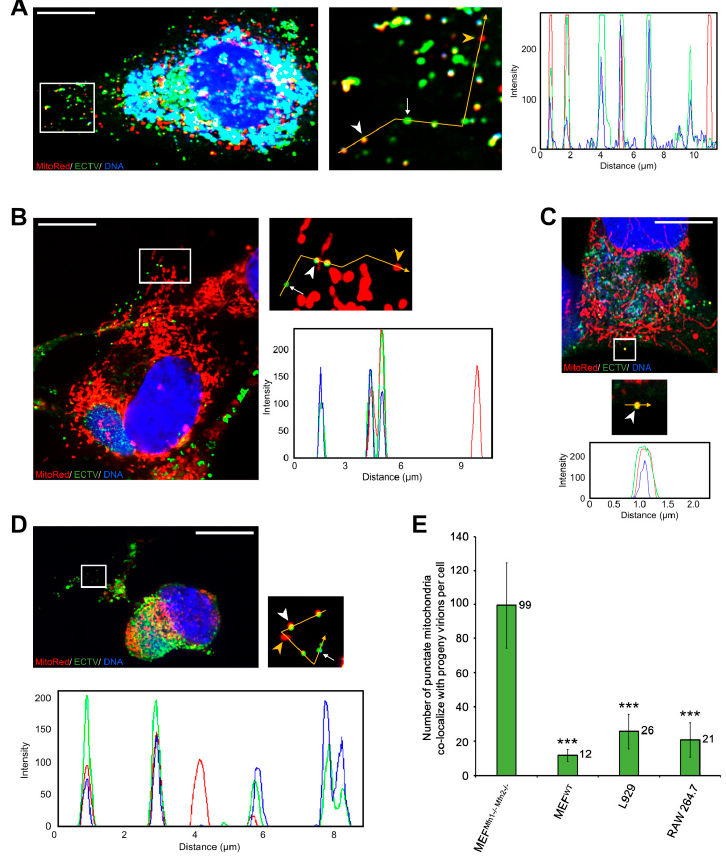
Figure 9. Co-localization of punctate mitochondria with ECTV progeny virions in MEF Mfn1 − / − /Mfn2 − / − ( A ), MEF WT ( B ), L929 ( C ), and RAW 264.7 cells ( D ) at 18 hpi. The fluorescence intensity of mitochondria (red line), ECTV antigens (green line), and viral DNA (blue line) was measured along the yellow segmented arrows ( A – D ). White arrowheads indicate punctate mitochondria co-localized with virions; white arrows indicate virions alone; yellow arrowheads indicate mitochondria alone ( A – D ). ( E ) The mean number of punctate mitochondria co-localized with ECTV progeny virions in MEF Mfn1 − / − /Mfn2 − / − , MEF WT , L929, and RAW 264.7 cells. Data from three independent experiments are presented as mean ± SD ( n = 20 cells). Student’s t -test; *** p ≤ 0.001. Scale bar: 10 µ m ( A – D